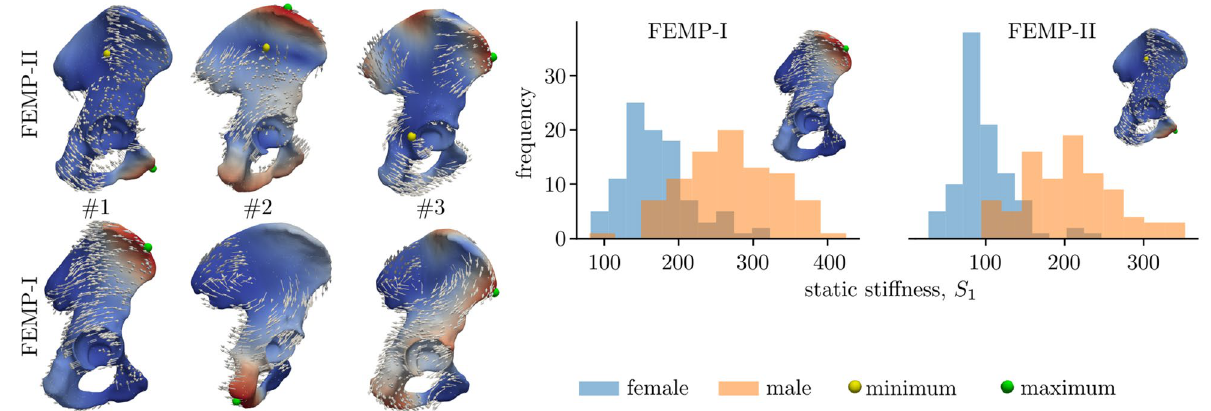
Figure 1. The description of eigenvectors associated with three modal stiffnesses. The arrows represent the direction of deformation. The scalar field represents the magnitude of eigenvector. Minimum markers are not shown for fixed model FEMP-I, given the minima are localized at fixed boundary locations shown in Fig. 6. The histograms show the static stiffness [N/mm], based on the first modal stiffness and considered as the smallest static